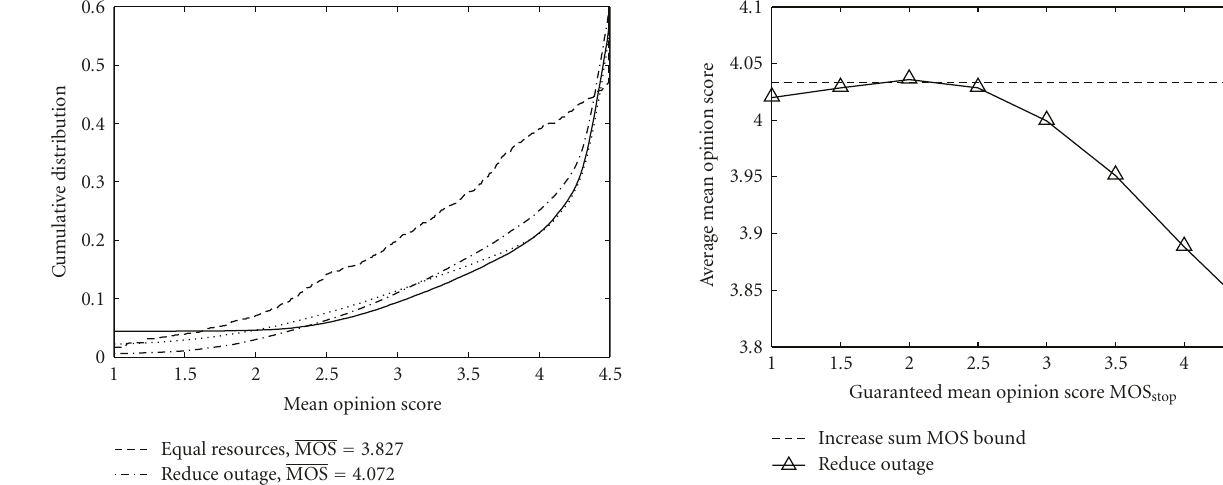
Figure 11: Average MOS as a function of the minimum MOS constraints MOS stop .